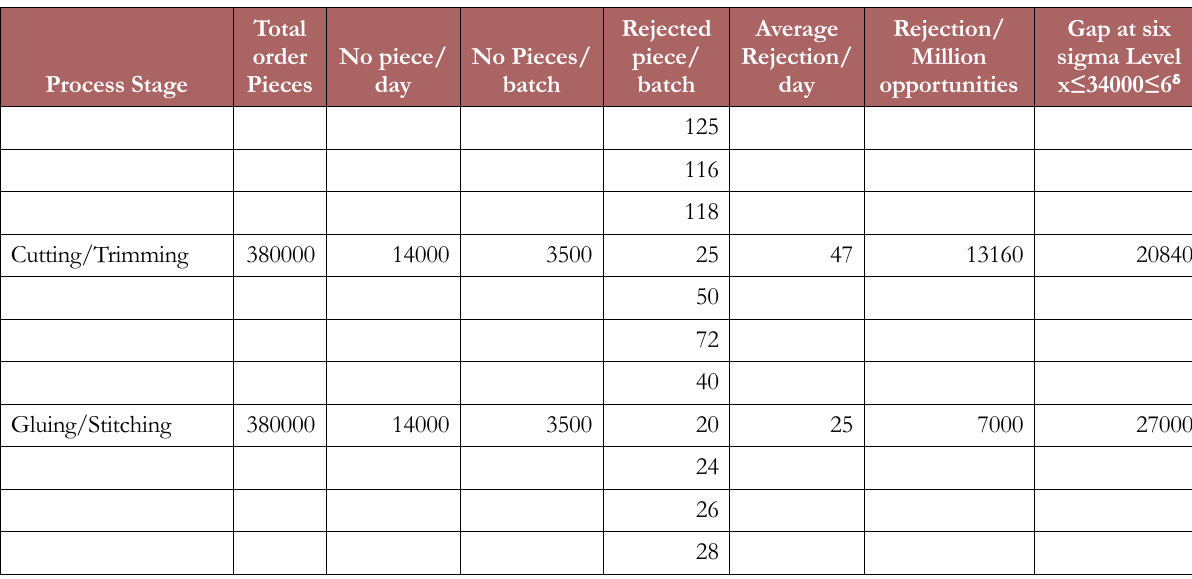
Table 9. Improved Estimation of Non-Conforming Products